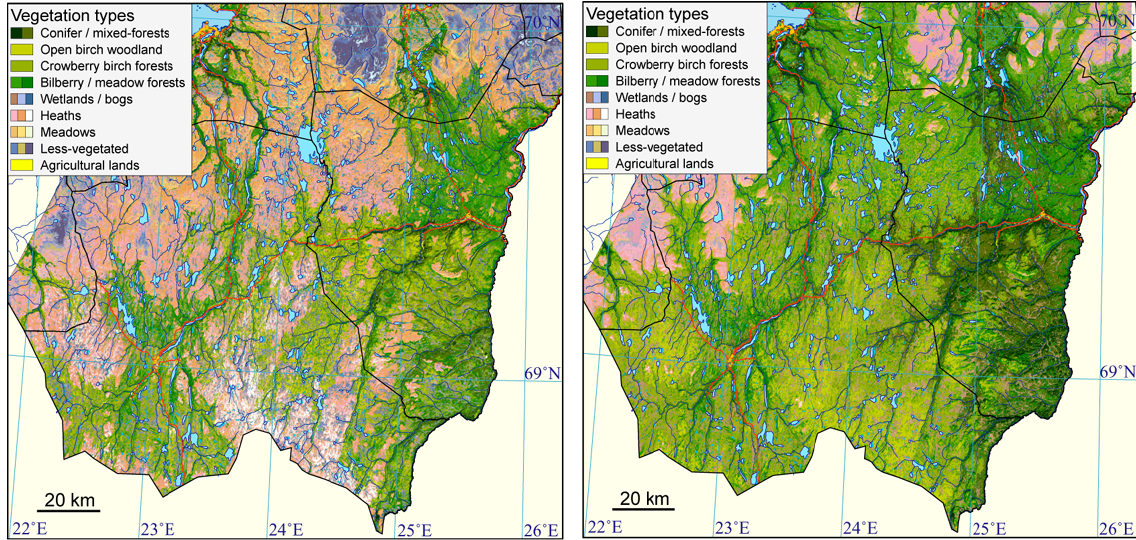
Fig. 2. (a) Current vegetation, redrawn from Johansen & Karlsen (2007). (b) A scenario map showing simulated potential forest distribution at 1°C increase of July